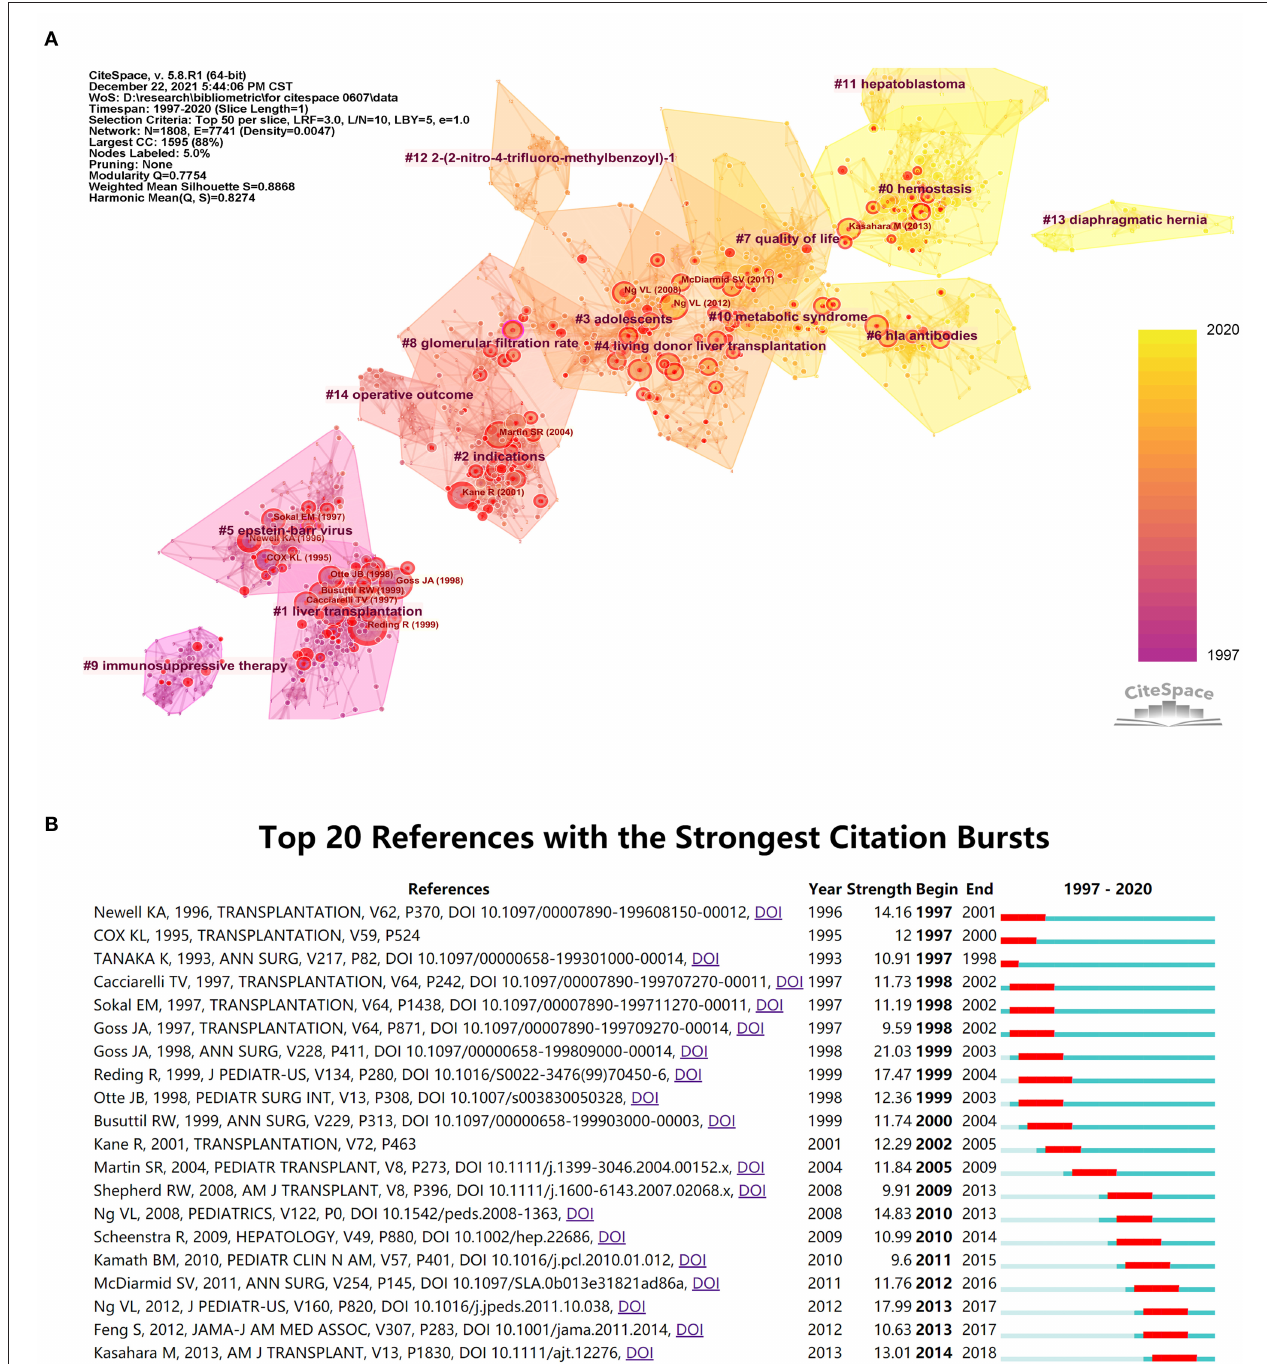
FIGURE 4 | Research fronts in pediatric liver transplantation (PLT). (A) A landscape view of the co-citation network, generated by top 50 per slice between 1997 and 2020. The network has modularity of 0.77, implying that the specialties are clearly defined. The average silhouette score is 0.88, suggesting that the homogeneity of the network is high. The nodes in the network are cited articles, and the links are the co-citation relationship between cited articles. Node sizes are proportional to the cited times of the articles. The areas of varied colors indicate the time when co-citation links in those areas appeared for the first time. (B) Top 20 references with the strongest citation